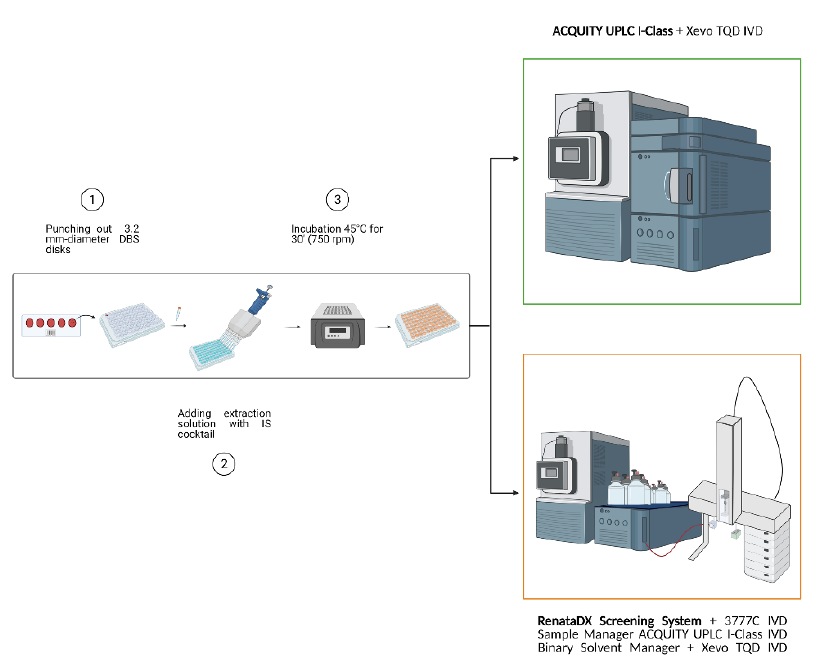
Figure 5. Workflow of sample preparation using NeoBase™ 2 Non-derivatized MSMS kit and parallel analysis by ACQUITY and RenataDX systems. Image created with BioRender.com.